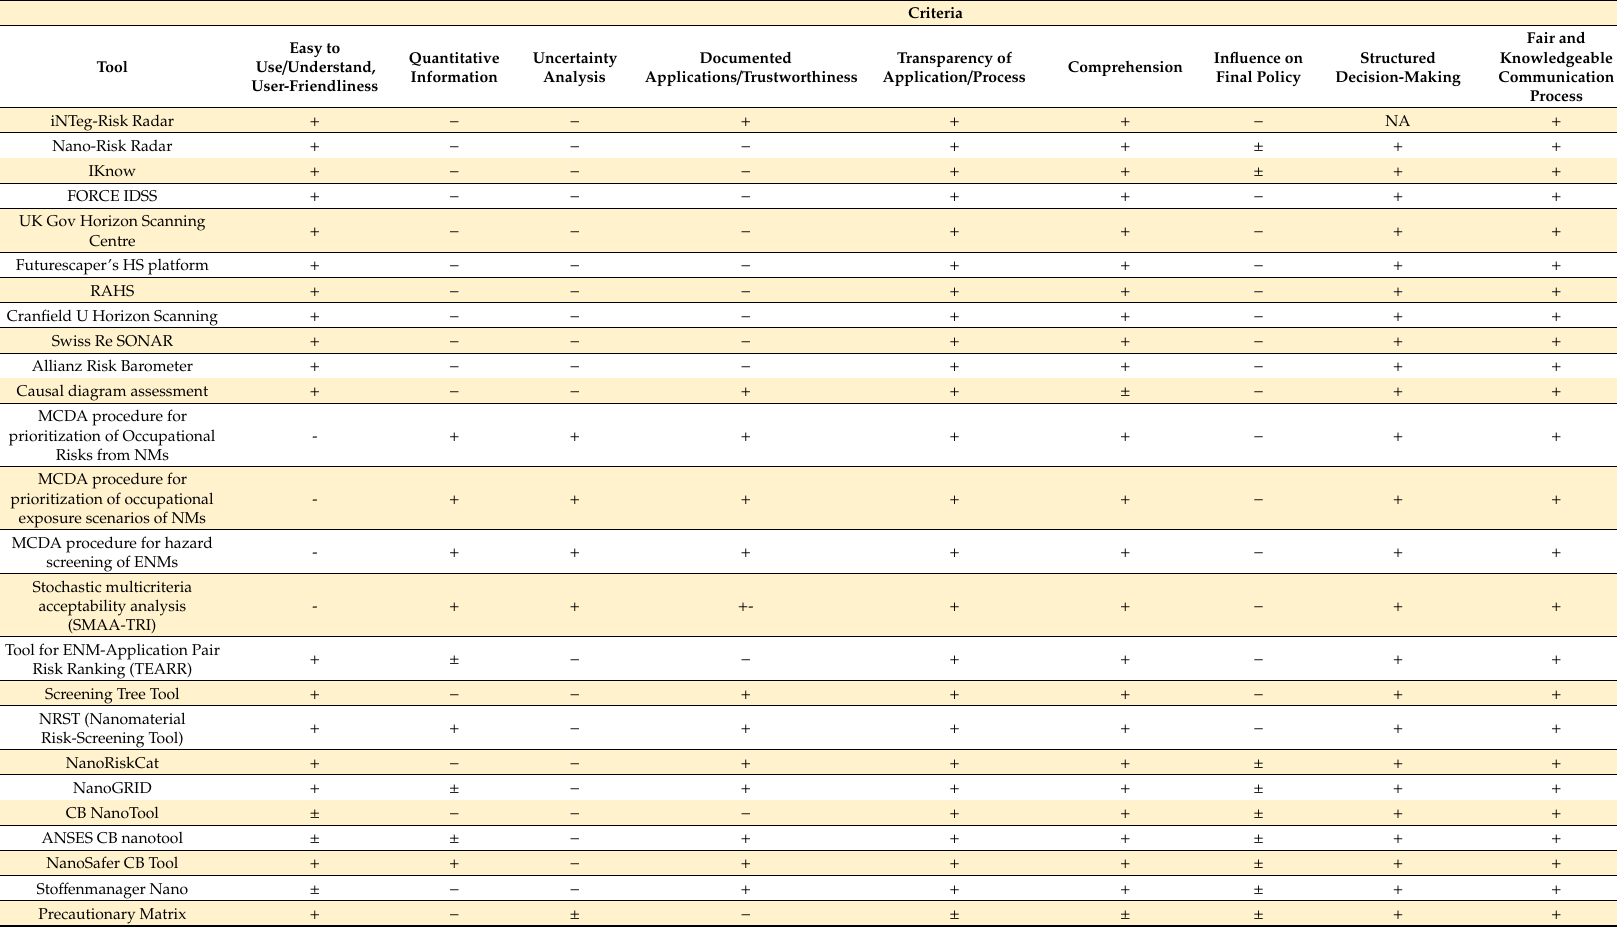
Table 2. Evaluation of the Risk pre-assessment tools, according to 9 relevant criteria. + Criterion fulfilled; − Criterion not fulfilled; ± Criterion not fully fulfilled; NA Criterion not applicable /